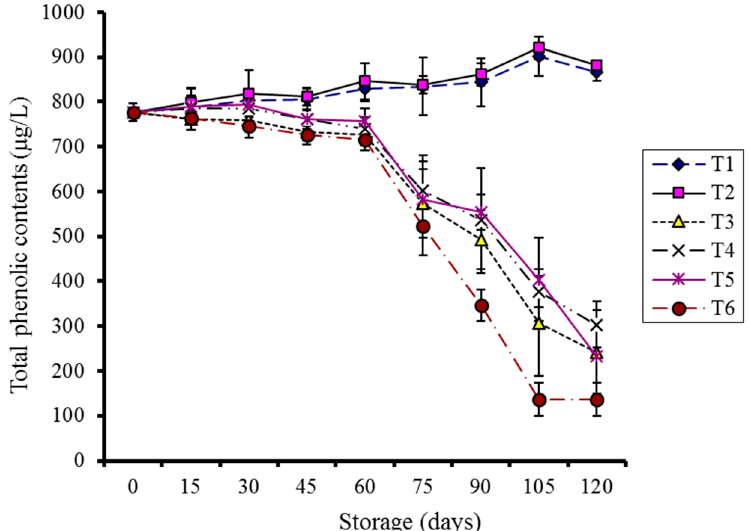
Figure 8. Effect of CMC and guargum-based silver nanoparticle coatings on the total phenolic contents of kinnow fruit stored at 4 and 10 °C during storage. The vertical bars represent standard error of the means. Values represented as mean ± SE of three replicates.